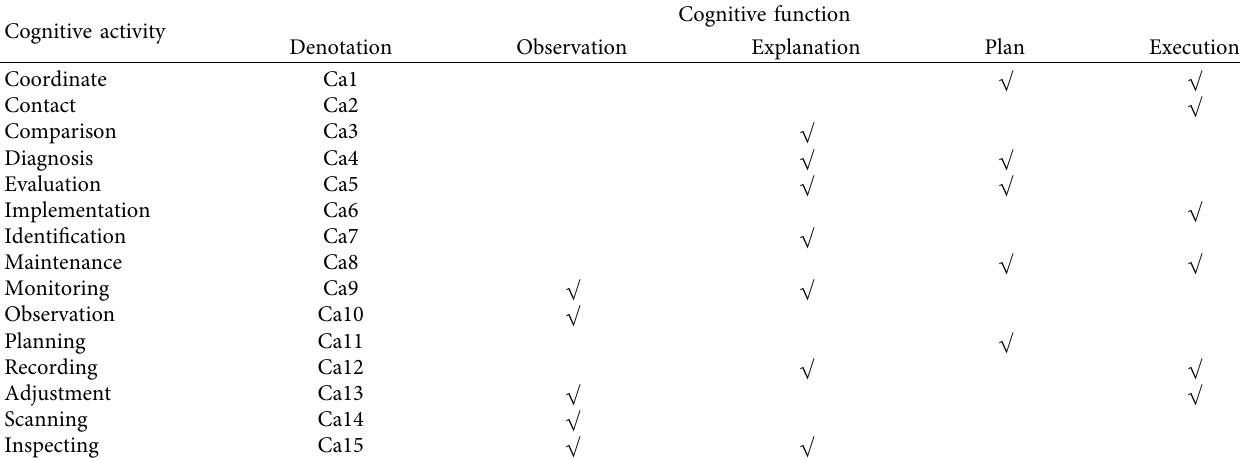
Table 2: Corresponding relationship of cognitive activity and cognitive